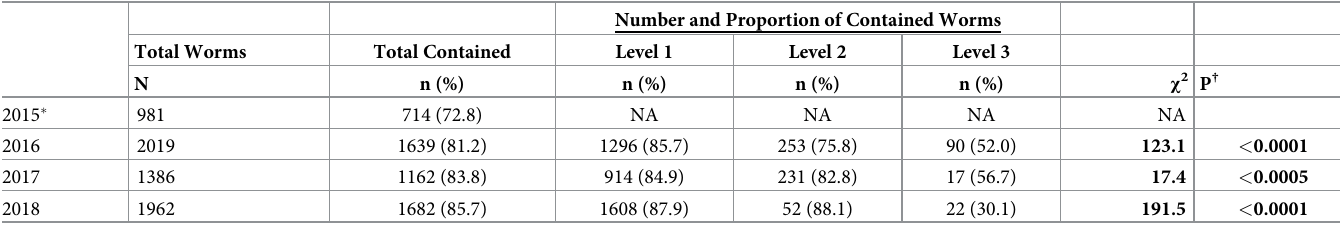
Table 2. Proportion of worms contained by surveillance level, 2015–2018.